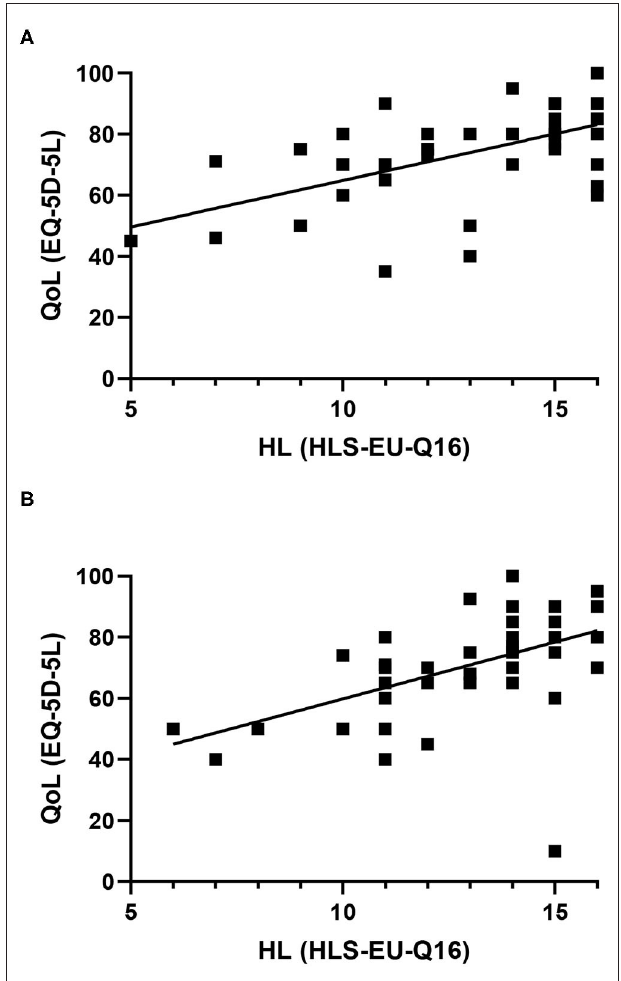
FIGURE 2 | Correlation between health literacy and quality of life in Crohn’s disease (A) and Diabetes mellitus (B)